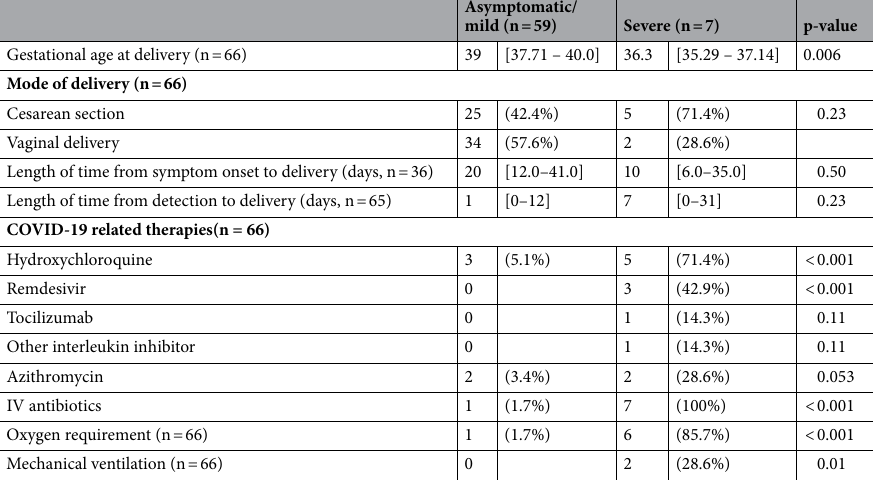
Asymptomatic/ mild (n =